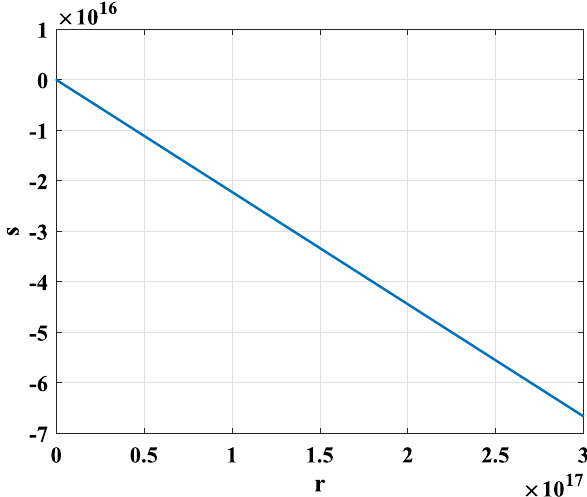
Fig. 13 Plot of v 2 s versus time ( t ) for k = 1 . 9, α 1 = 1 . 2, α 2 = 0 . 52, γ = 101, and β = − 0 . 1 , − 0 . 3 , − 0 . 5 1